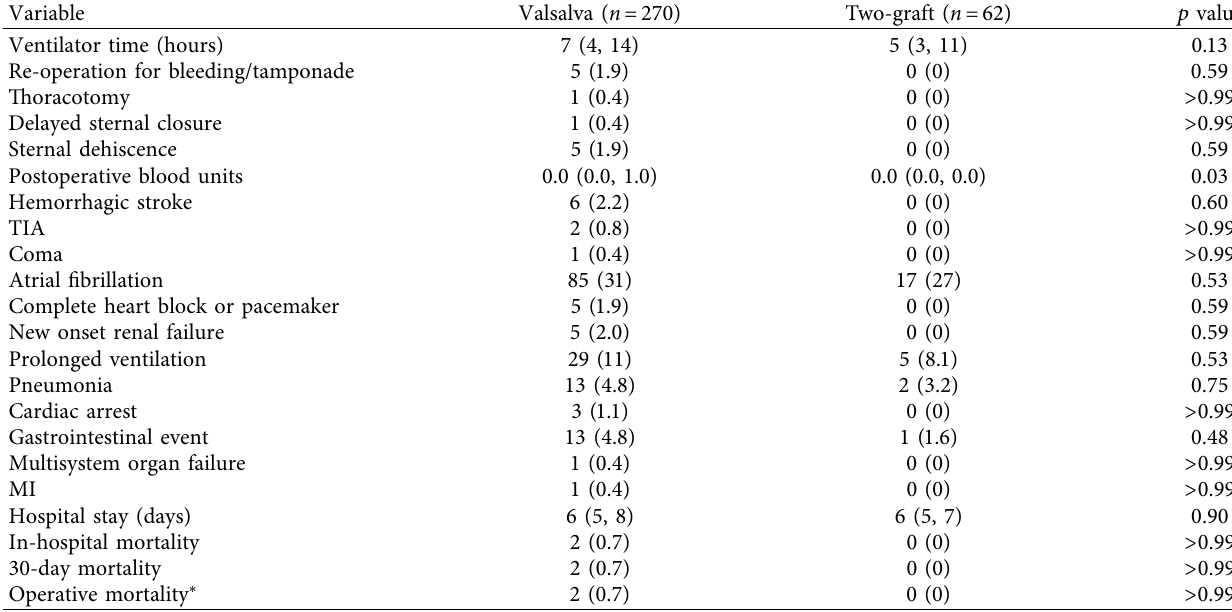
Table 3: Perioperative